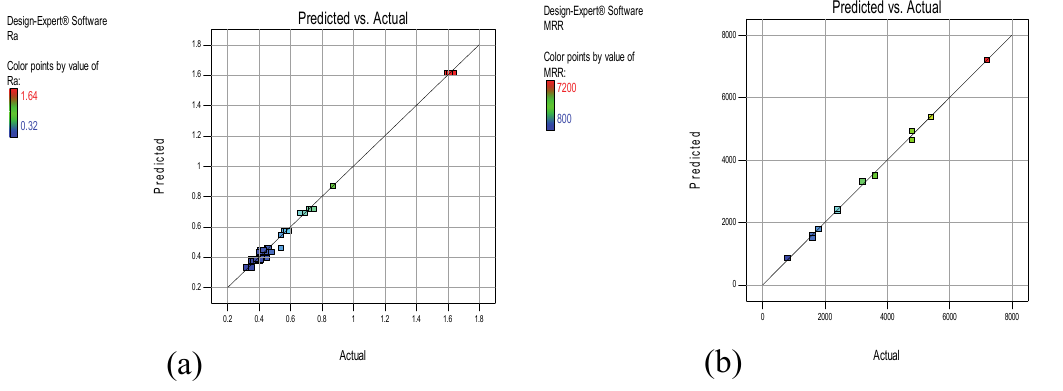
Fig. 11. Comparison between predicted and experimental results (a) for Ra and (b) for